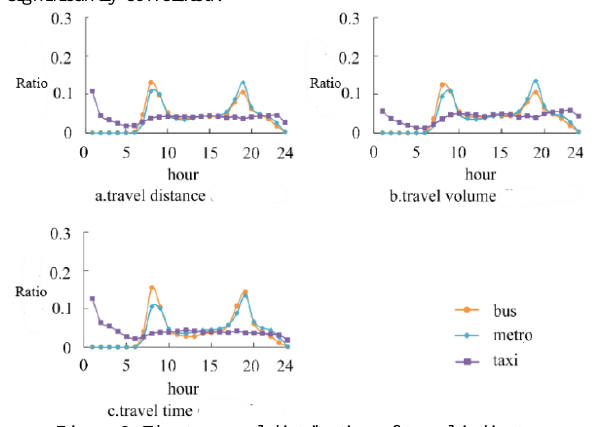
Figure 3. The temporal distribution of travel indicator